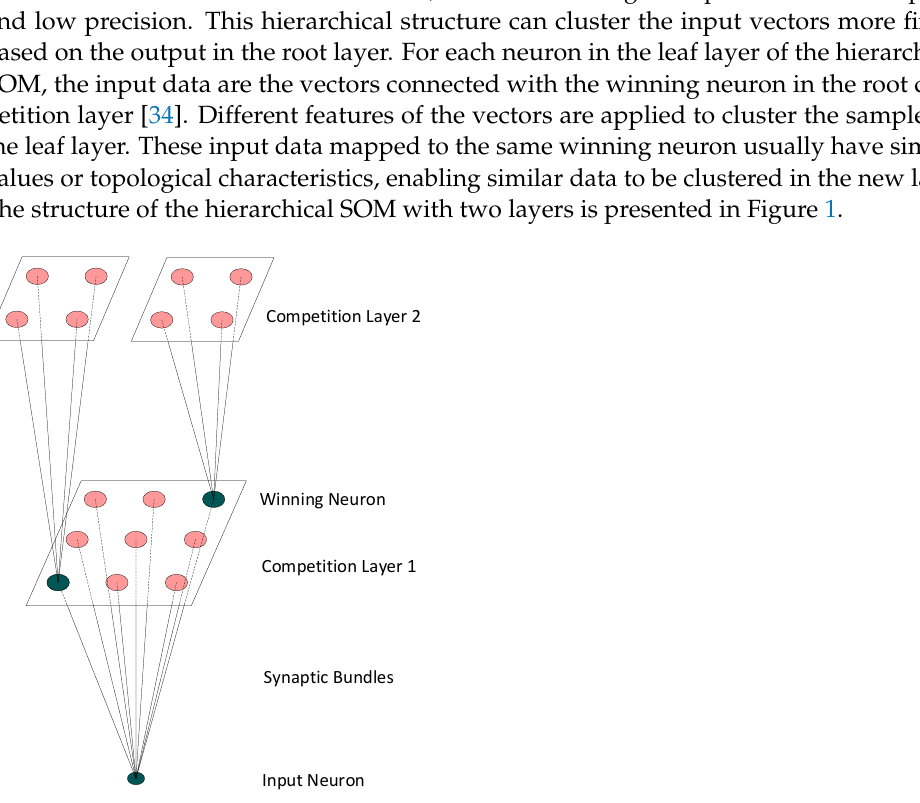
Figure 1. The structure of the hierarchical SOM